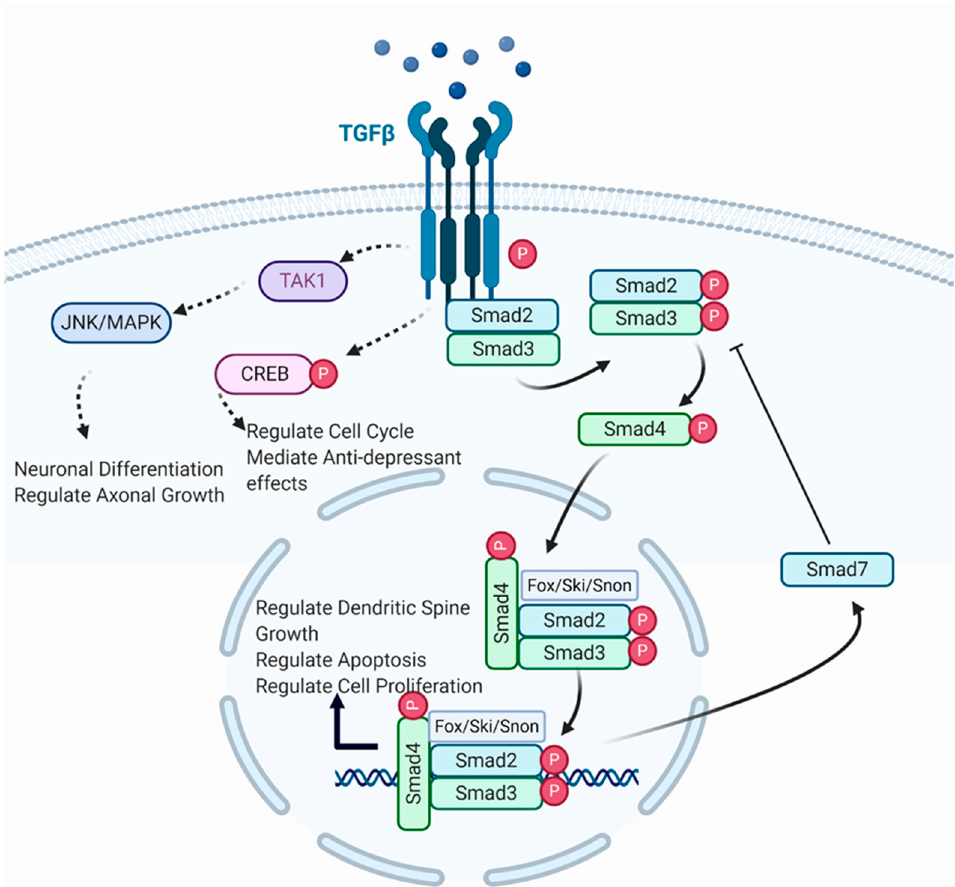
Figure 1. Illustration of canonical and non-canonical TGF- β signalling. TGF- β ligand binds with TGF- β receptor to form a complex (Created with BioRender.com, accessed on 19 April 2021). The receptor-induced phosphorylation of R-Smads leads to binding with cytoplasmic Smad2/3. Phosphorylated Smads form a complex with Smad4, which translocates to the nucleus where it binds with various transcription factors for gene transcription. Smad complexes initiate a negative feedback loop, leading to Smad7 inhibition of further phosphorylation of R-Smads. TGF- β receptors also phosphorylate TAK1 and CREB, which regulate neuronal differentiation, axonal growth, cell cycle progression, and anti-depressant effects, respectively.